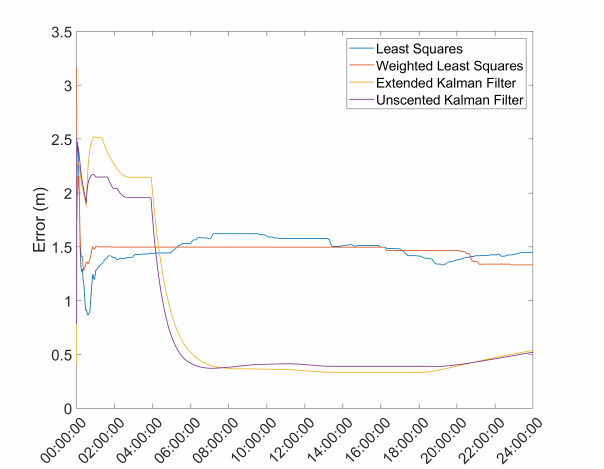
Figure 7. Effect of a 1 σ threshold on the mean error over time for the reference station antenna with Hatch Filter and γ =